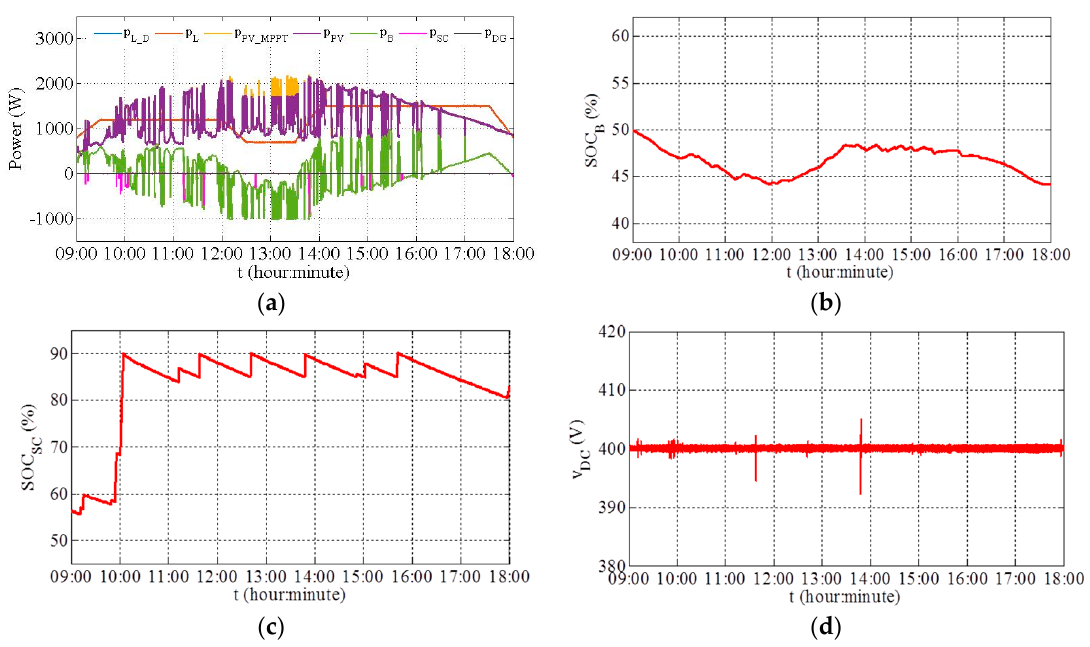
Figure 9. Experimental results of test 2: ( a ) DC microgrid power evolutions, ( b ) SOC evolution of battery bank, ( c ) SOC evolution of the SC, and ( d ) DC bus voltage.